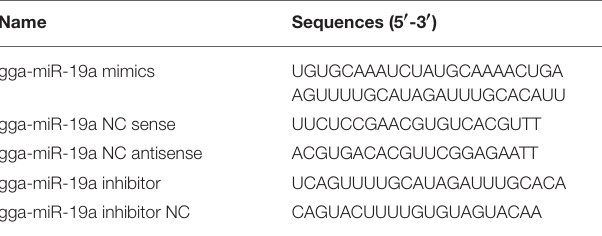
TABLE 2 | Sequences of RNA oligonucleotides.